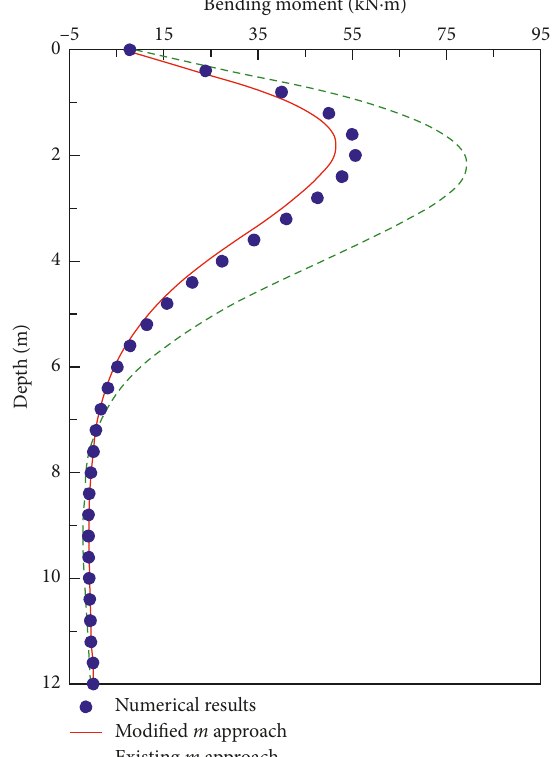
Figure 11: Comparison of predicted pile moments from the modified and existing m approach and numerical results at a lateral load of